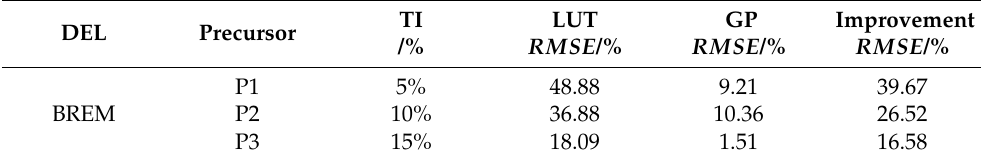
Table 6. RMSE error of blade root flapwise